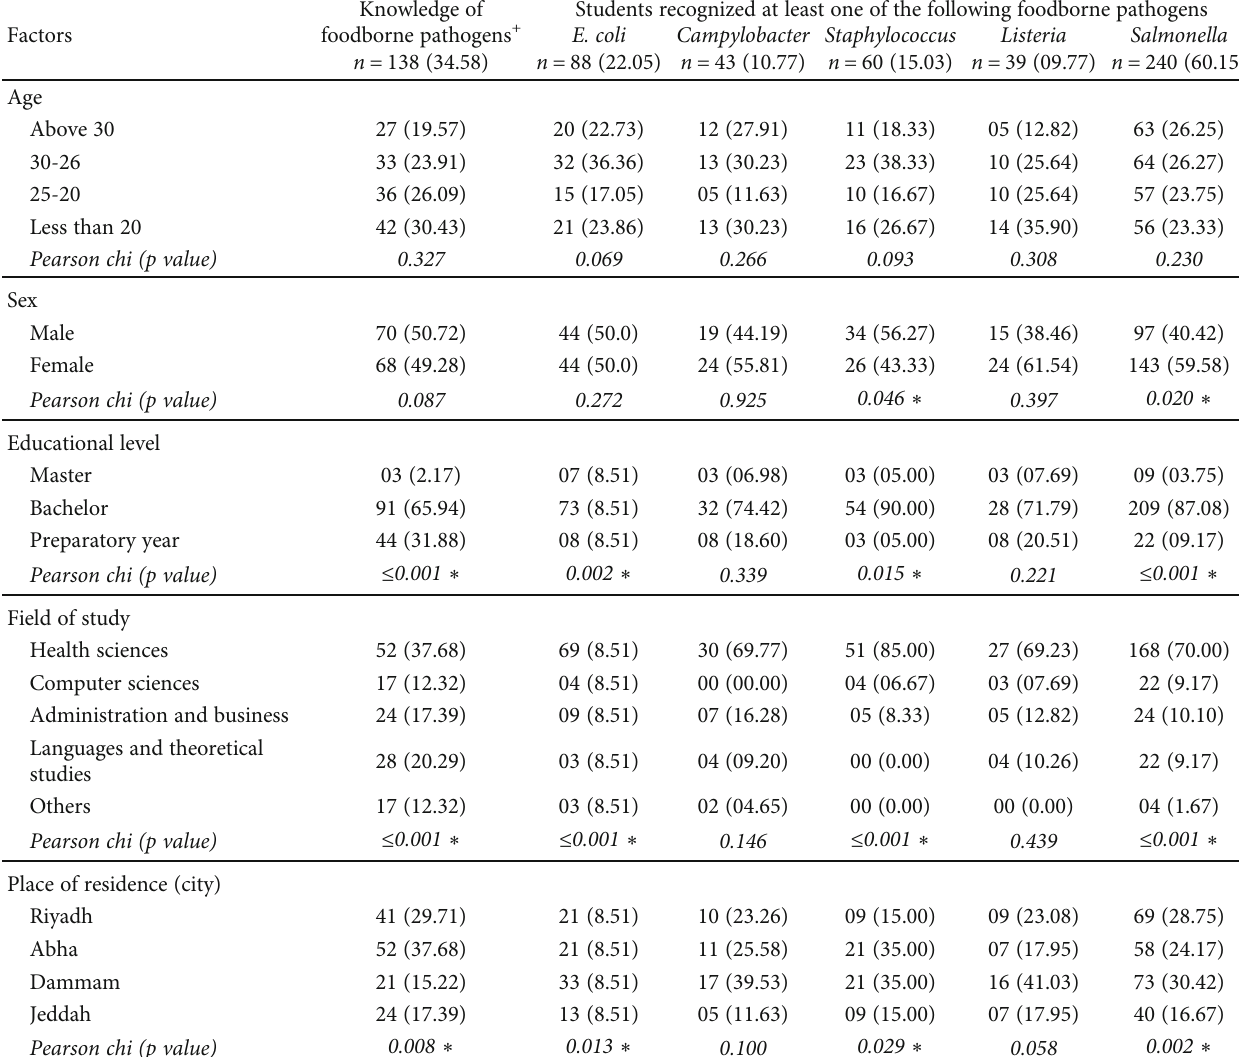
Table 2: Association of students ’ knowledge of foodborne pathogens with their sociodemographic characteristics ( N = 399